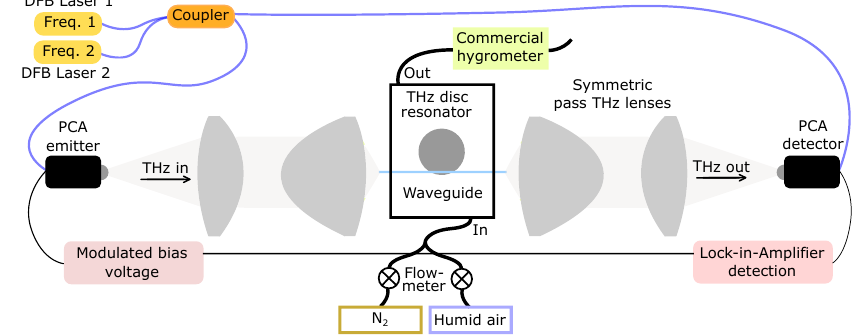
Figure 2. Schematic of the gas-phase THz spectrometer with a commercial CW-THz system and a sub-wavelenth thick THz disc microresonator. The THz microresonator is mounted on a 3D translation stage to control the position of the resonator relative to the air-flouropolymer-silica waveguide. Both the horizontal and vertical position of the waveguide relative to the resonator were monitored with digital microscopes. Because of the intriguing field distribution, best coupling is achieved by placing the waveguide above or below the edge of the disc. Strong coupling is typically achieved at a position of the waveguide of about 200 µ m inside from the edge of the microresonator and a gap of about 100 µ m–200 µ m to the microresonator. The deployed symmetric-pass THz lenses are specifically designed to achieve high coupling efficiency to the sub-wavelength waveguide